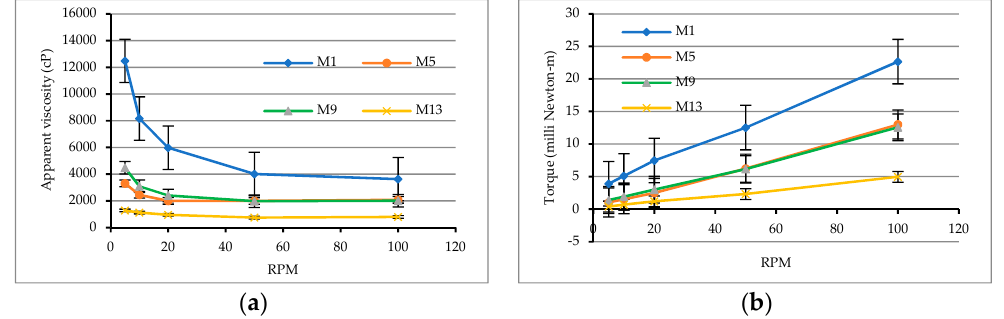
Figure 3. Rheological test results of pure cement pastes: ( a ) relationship between viscosity and spindle speed; ( b ) relationship between torque and spindle speed.